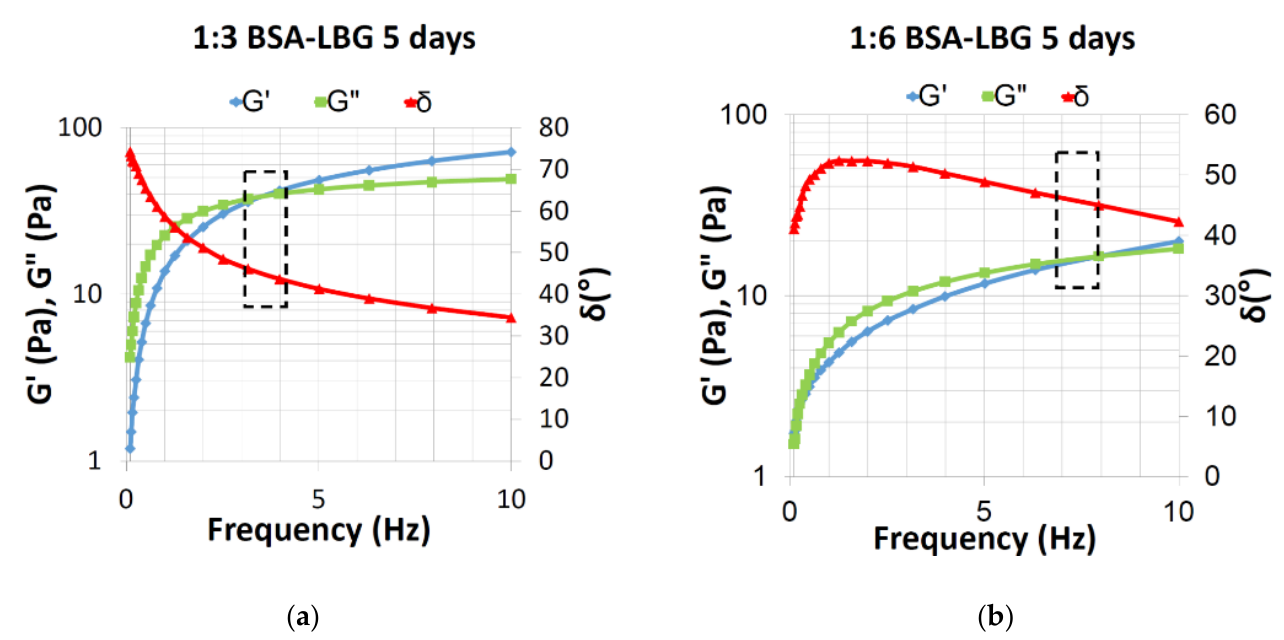
Figure 4. Storage modulus (blue line, G′), loss modulus (green line, G″) and phase angle (red line, δ) for BSA–LBG 1:3 and BSA–LBG 1:6 conjugates (25 °C). Table 2. Calculated viscosity values by linear interpolation